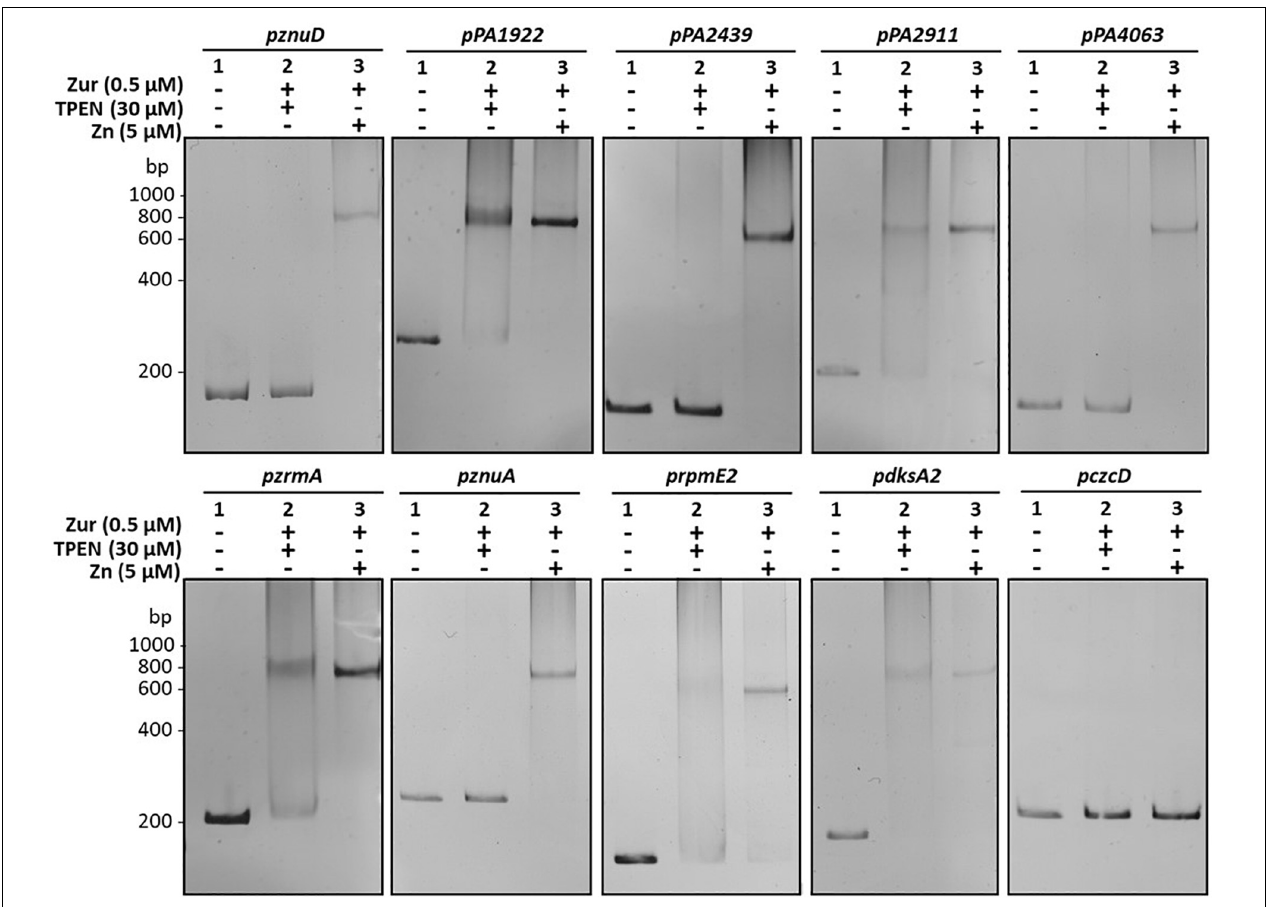
FIGURE 6 | Zur binds to the diverse zur box with different affinities. Electrophoretic mobility shift assays using purified Zur protein and the different target promoters. The czcD promoter ( pczcD ) was used as a negative control. 30 ng of DNA were mixed with (1) 0 nM of Zur, 5 µ M ZnCl 2 ; (2) 500 nM Zur and 30 µ M TPEN (Zn depleted condition); and (3) 500 nM Zur and 5 µ M ZnCl 2 , as indicated. Reactions were loaded on non-denaturing 7.5% polyacrylamide gels, stained with ethidium bromide and viewed under UV